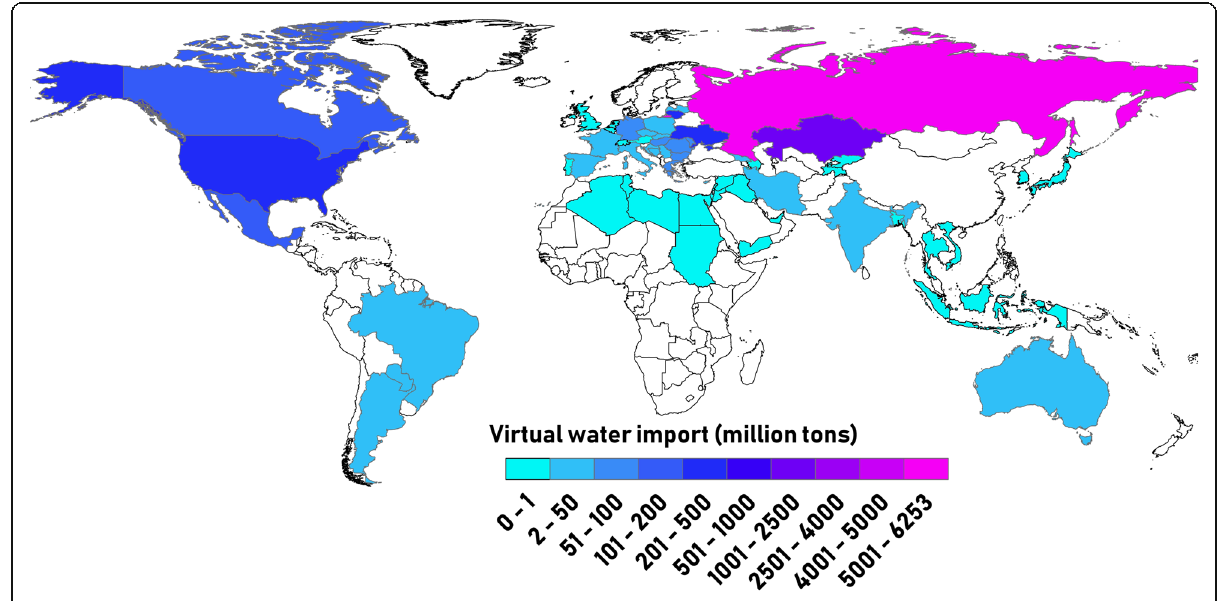
Fig. 8 Illustration of Turkey ’ s virtual water